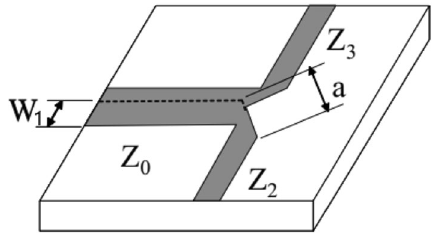
Figure 20. T-type